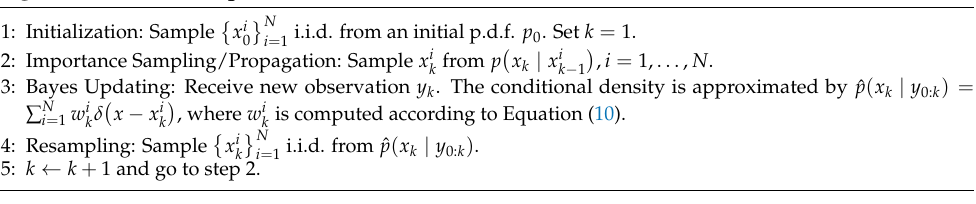
Algorithm 1 General particle